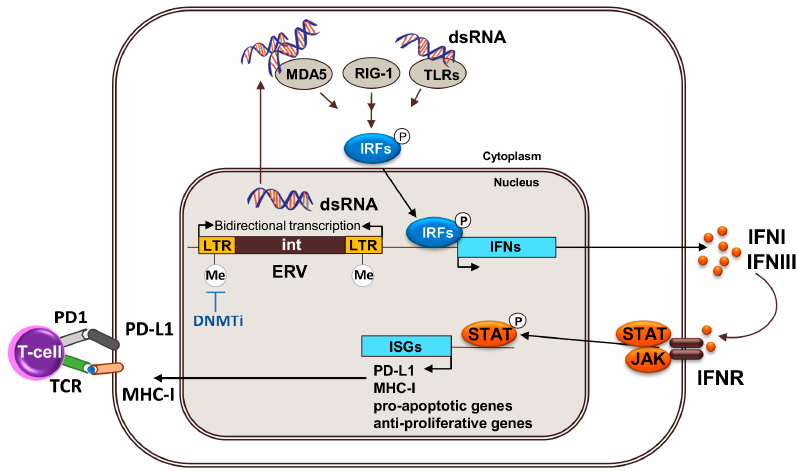
Figure 3. DNMTs inhibitors activate the expression of endogenous retroviruses in cancer cells. Treatment with DNMTs inhibitors (blue arrow) causes loss of DNA methylation in the long terminal repeats (LTR) of endogenous retroviruses (ERVs) and activation of bidirectional transcription, which leads to the formation of double-stranded RNA (dsRNA). dsRNA are sensed in the cytoplasm by cytosolic receptors MDA5/RIG-I/LTRs that initiate signaling cascades to mediate the phosphorylation of interferon responsive factors (IRFs) that, in turn, activate the expression of target genes in the nucleus, including IFNs. INFs activate JAK/STAT-dependent signaling pathways, which result in the induction of interferon stimulated genes